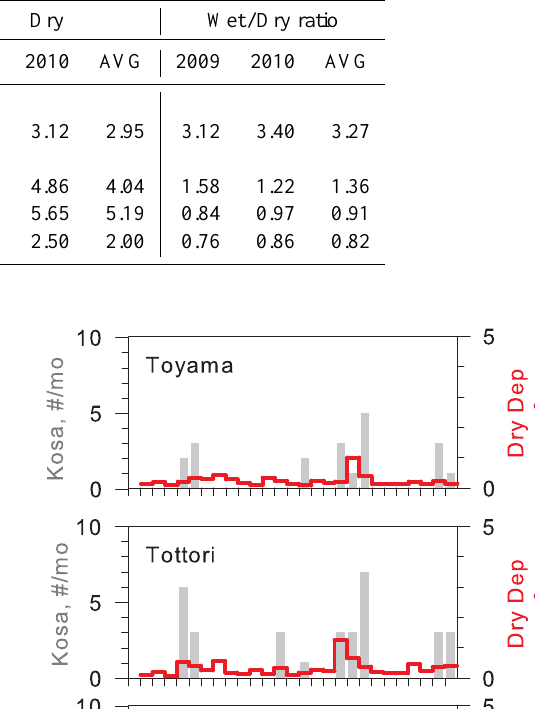
Table 1. Annual deposition flux (gm − 2 yr − 1 ) of mineral dust Wet Dry Wet/Dry ratio